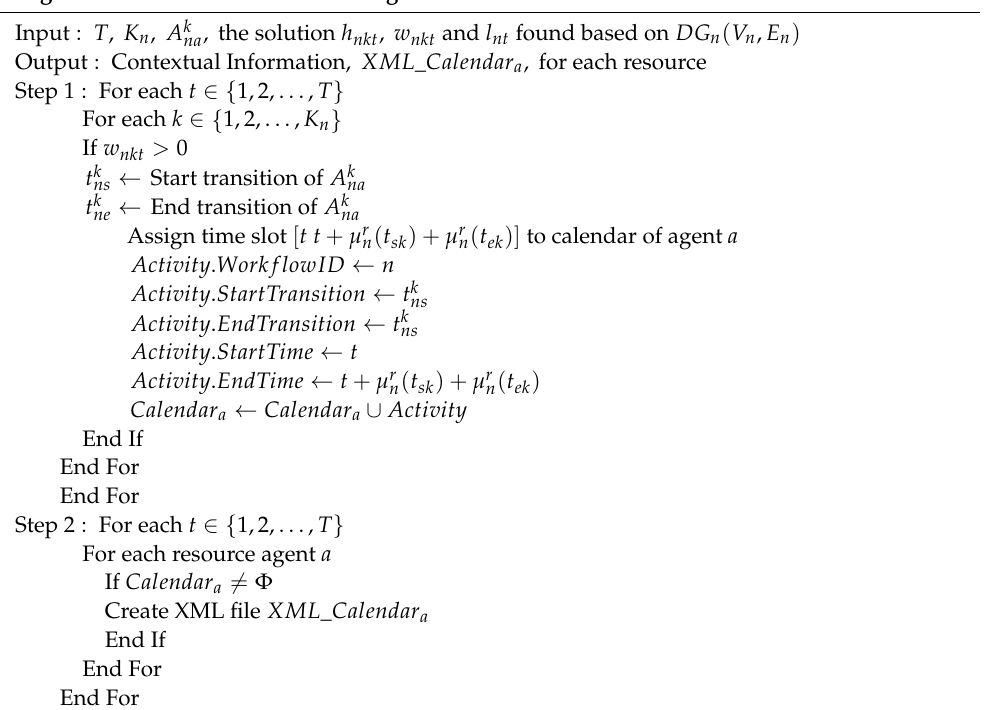
Algorithms 2 Context Generation